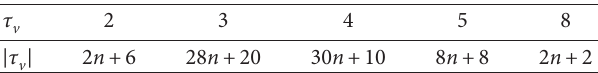
Table 2: Partitions of H ’s vertices according to the connection number.